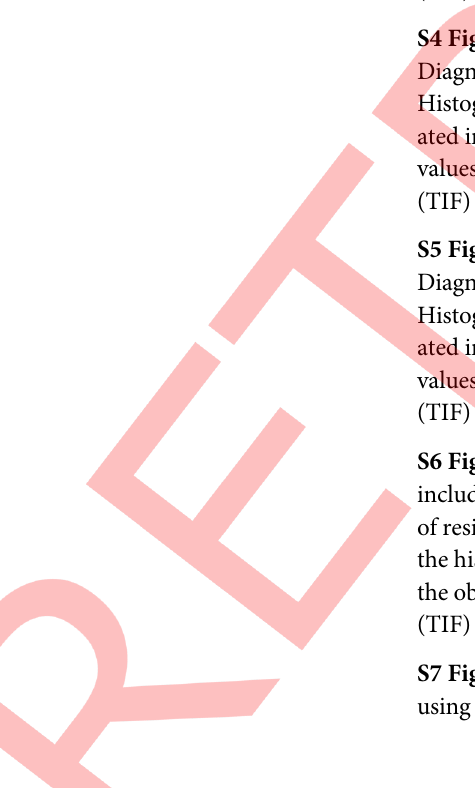
S3 Fig. (fringe metro) ( N k ¼ 2